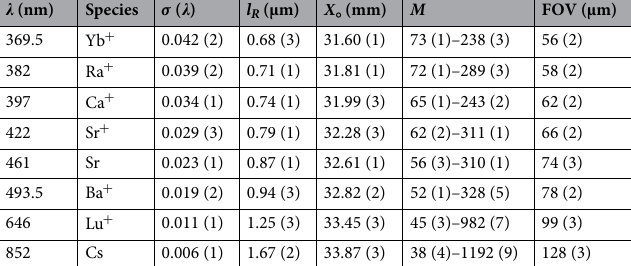
(cid:31) (nm) Species σ ( (cid:31)